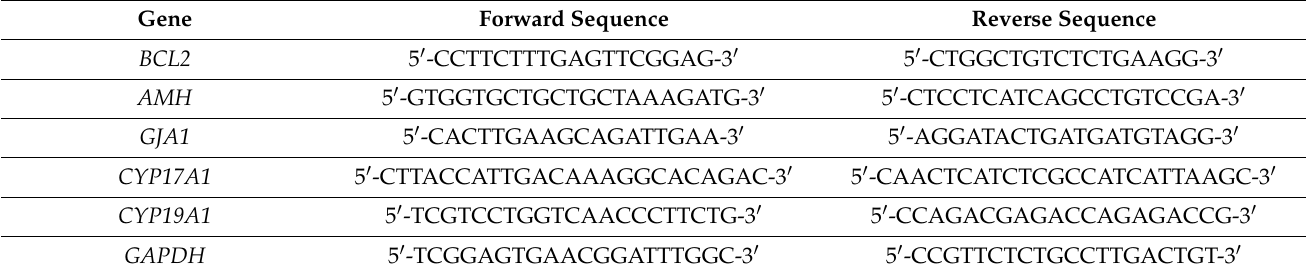
Table 6. Sequences of primers used in real-time